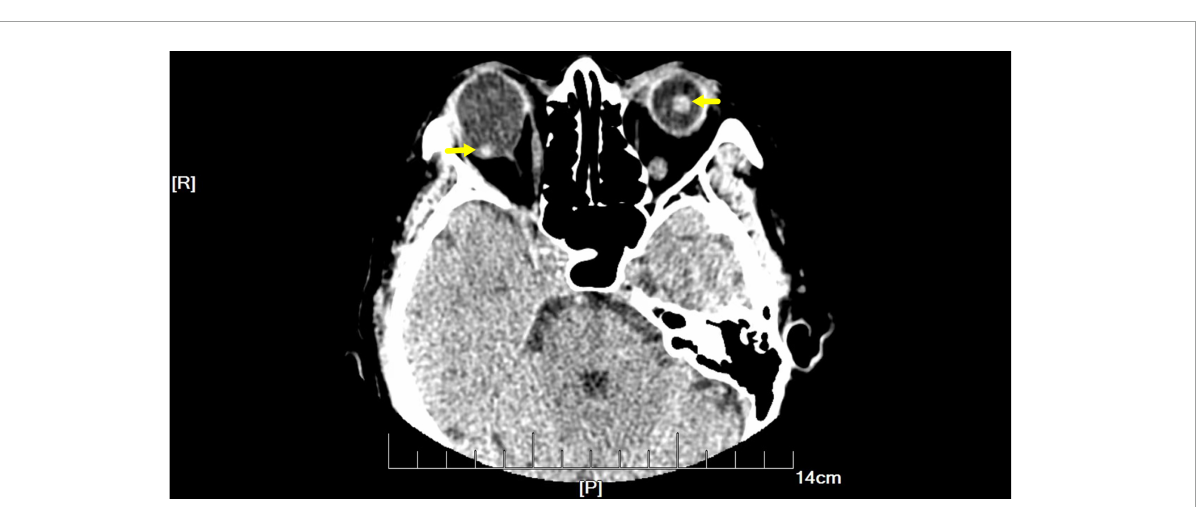
FIGURE2 Orbital computed tomography (CT) demonstrated free-floating lenses in the posterior poles (yellow arrows).